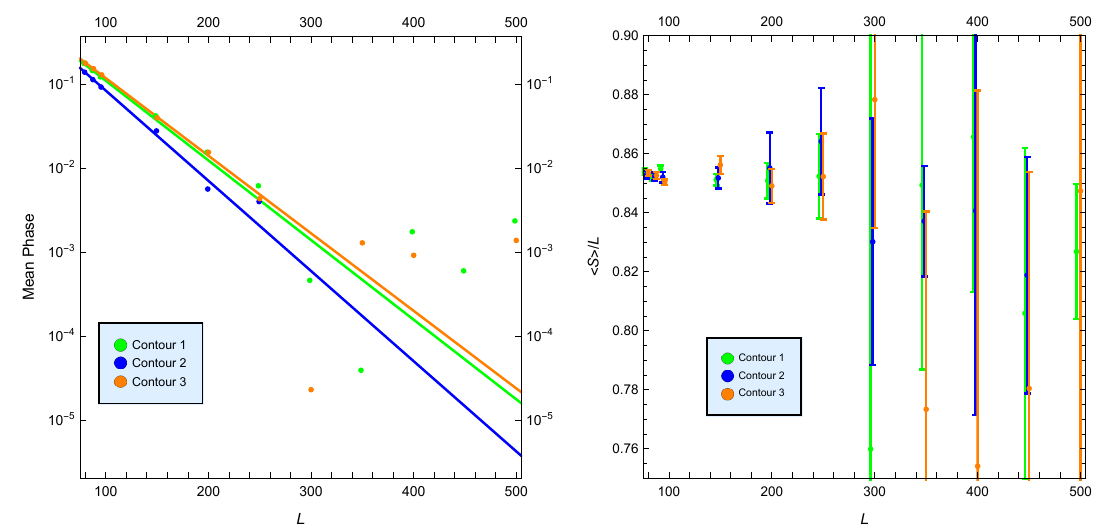
Figure 5 . The onset of the sign problem for contours 1,2,3. Left: the mean phase as a function of lattice size on a logarithmic scale together with the previously obtained linear (cid:12)ts. Right: the action density as a function of lattice size. The various contours are colour marked. Di(cid:11)erent contours are separated horizontally for clarity.